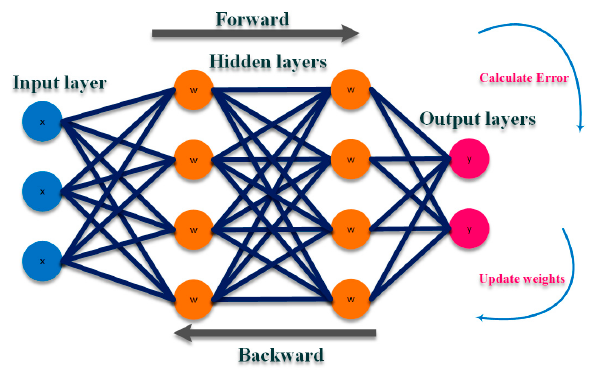
Figure 21. Sample DNN with a backpropagation algorithm.